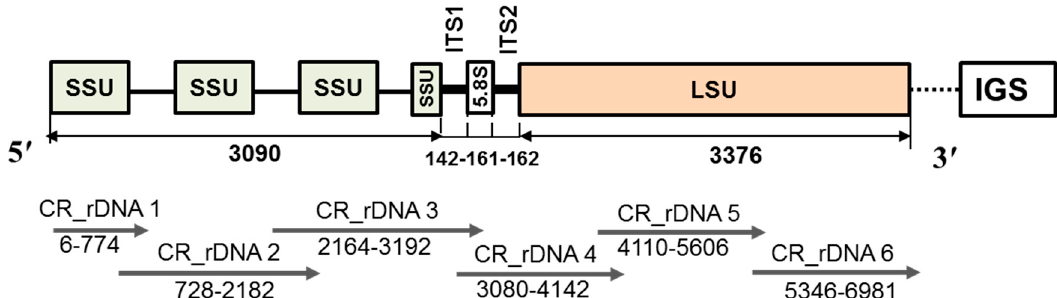
Figure 1. Schematic structure of the ribosomal DNA (rDNA) of P. brassicae. SSU, small subunit; LSU, large subunit; ITS, internal transcribed spacer; IGS, intergenic spacer based on literature [31,32]; CR_DNA (from 1 to 6) indicates marker sequences developed for cloning the target regions. Marker sequences are given in Table 1. Numbers in the figure are lengths in base pairs (bp) of each subunit cloned and sequenced in this study. The dotted line in-between LSU and IGS at the 3 ′ end indicates uncompleted sequences. Arrows from 5 ′ to 3 ′ direction indicate length of primers.